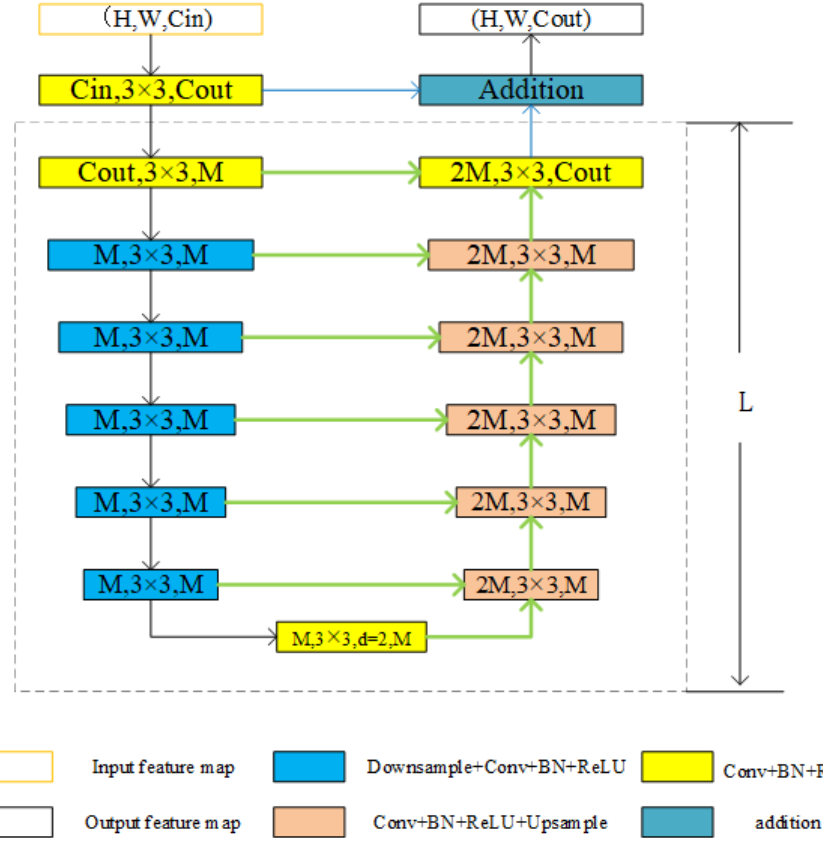
Figure 2. Residual U-blocks [52]. A residual unit composed of a U-shaped structure. The dashed frame is a U-shaped block. The feature map obtained by the convolution operation and the output result of the U-shaped block are added to obtain the output feature map.